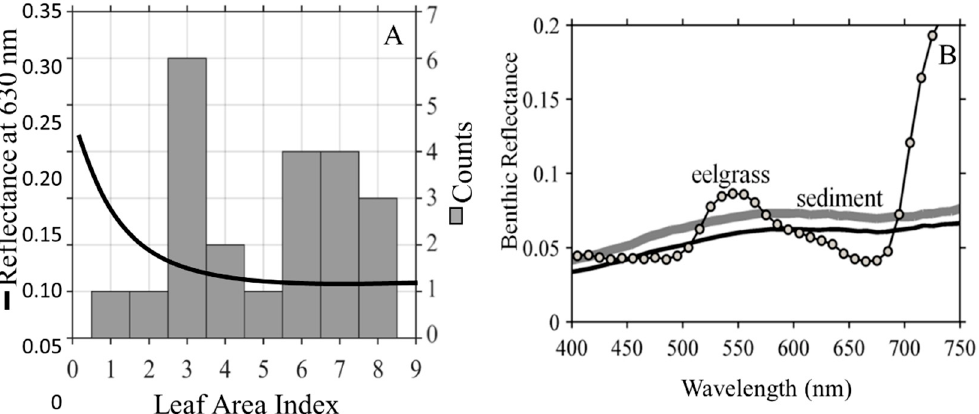
Figure 4. ( A ) A histogram of the eelgrass Leaf Area Index (LAI) measured along the various transects in Otter Curve and Seal Bend (left axis) with LAI values largely greater than 3 in this region. The solid black line represents the modeled relationship between LAI and Reflectance at 630 nm (right axis) from Hedley et al. (2017) revealing that the signal saturates for dense eelgrass canopies with LAI’s greater than ~3 [11]. ( B ) Benthic reflectance of sediment measured by divers both within and outside the eelgrass beds (solid lines) compared to eelgrass leaf reflectance measured in the laboratory (dotted line).